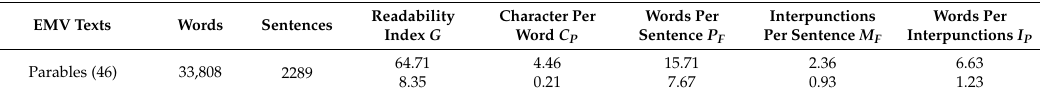
Table 1. Total number of words and sentences. Statistics of readability index G , number of text characters per word ( C P ), number of words per sentence ( P F ), number of punctuation marks per sentence ( M F ) and number of words per punctuation marks, namely the word interval ( I P ), all values calculated as discussed in general terms in [4], for all the diverse audiences. For better comparing the texts addressed to diverse audience, standard deviations—reported in the second line—are referred to text blocks of 250